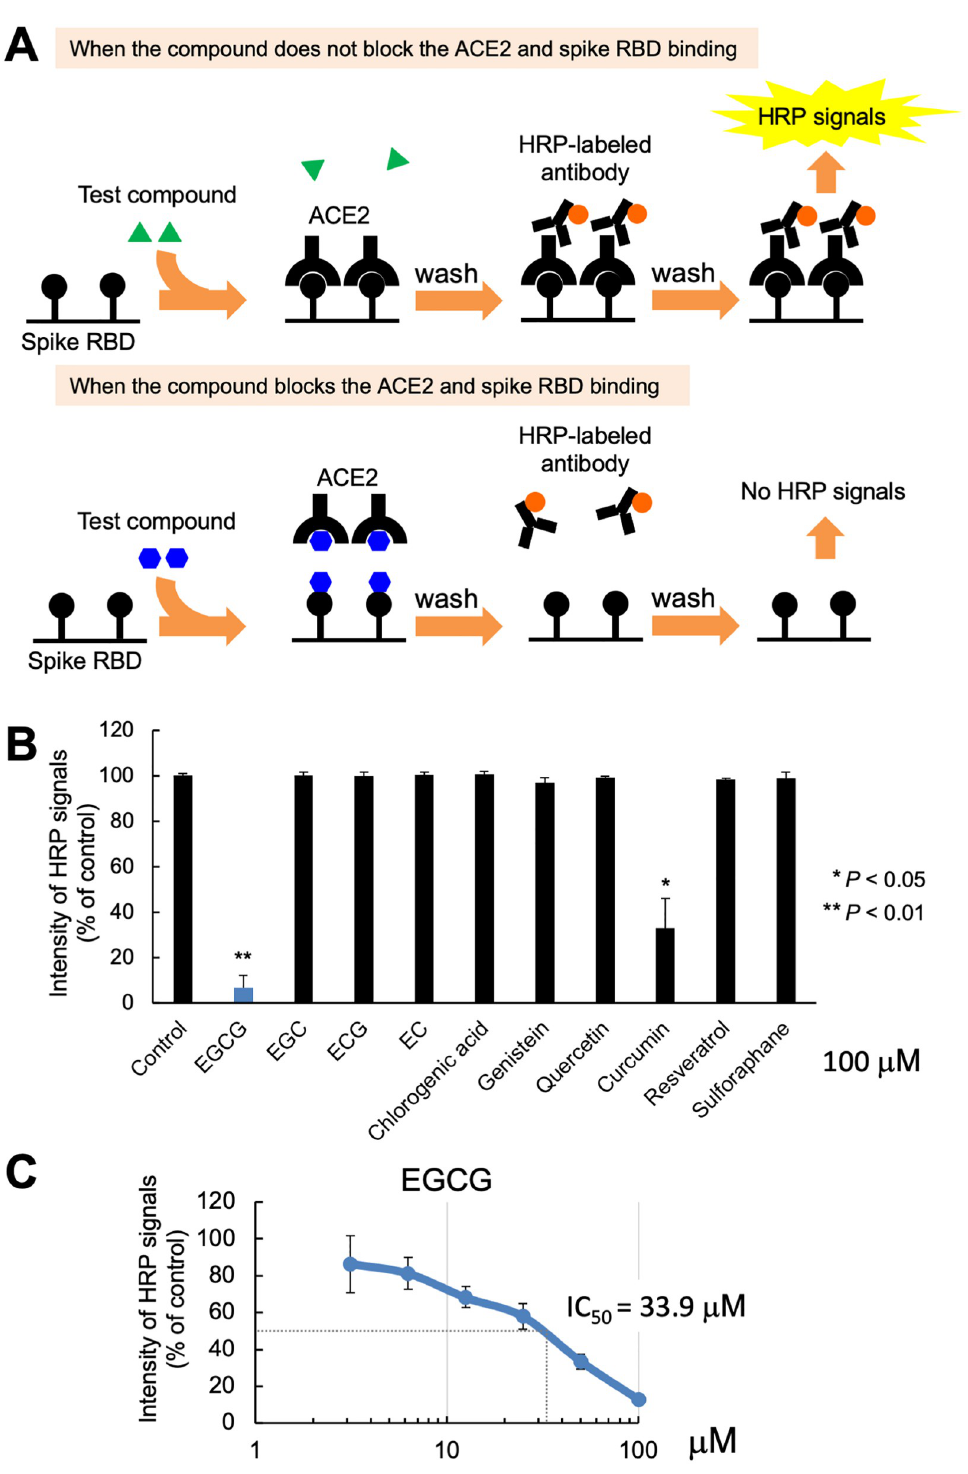
Fig 2. Epigallocatechin gallate (EGCG) inhibits the interaction between the spike receptor-binding domain (RBD) and human cell receptor angiotensin-converting enzyme 2 (ACE2). (A) Schematic of the ELISA-based screening of phytochemical inhibitory activity on ACE2 and SARS-CoV-2 spike RBD binding. Upper scheme: When the compound does not block the ACE2 and spike RBD binding. Lower scheme: When the compound blocks the ACE2 and spike RBD binding. (B) ELISA results of phytochemical inhibition of the ACE2 and spike RBD binding. Low-intensity HRP